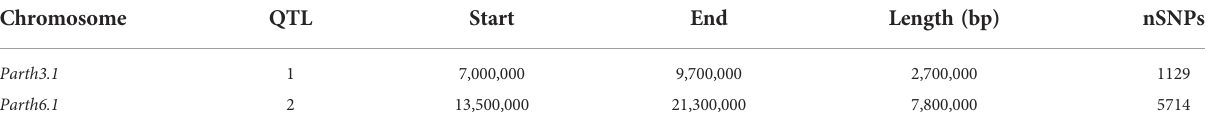
TABLE 3 Identi fi ed QTL regions in cucumber for parthenocarpy and their distribution in chromosome 3 and 6. Chromosome QTL Parth3.1